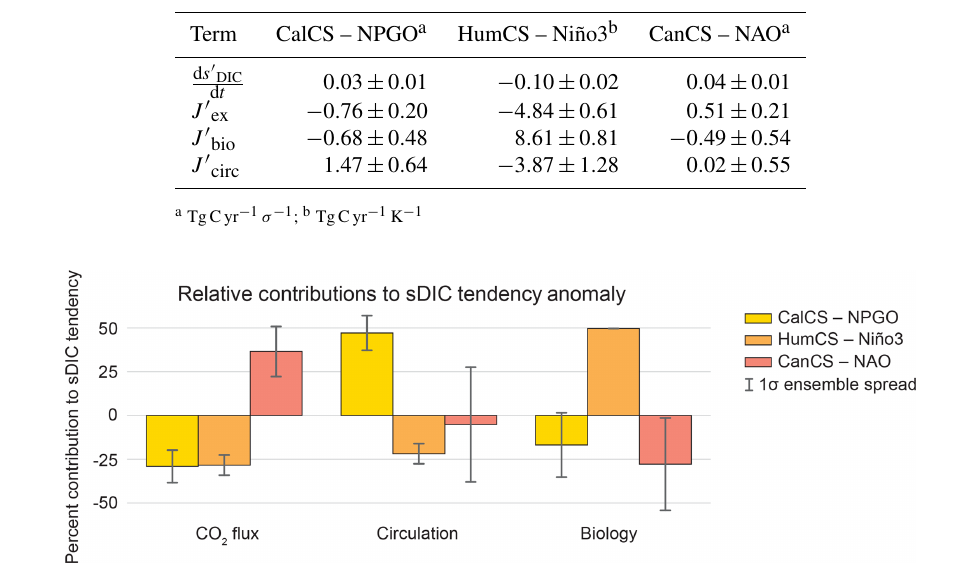
Figure 10. Relative contributions of anomalous air–sea CO 2 flux, physical circulation, and biology to the approximated s DIC tendency anomaly for the CalCS (yellow), HumCS (orange), and CanCS (red) in response to the NPGO, Niño3, and NAO, respectively. Error bars show the 1-standard-deviation spread of the ensemble. For a given simulation, the absolute magnitude of the three components sum to 100%. These values were approximated using Eq.